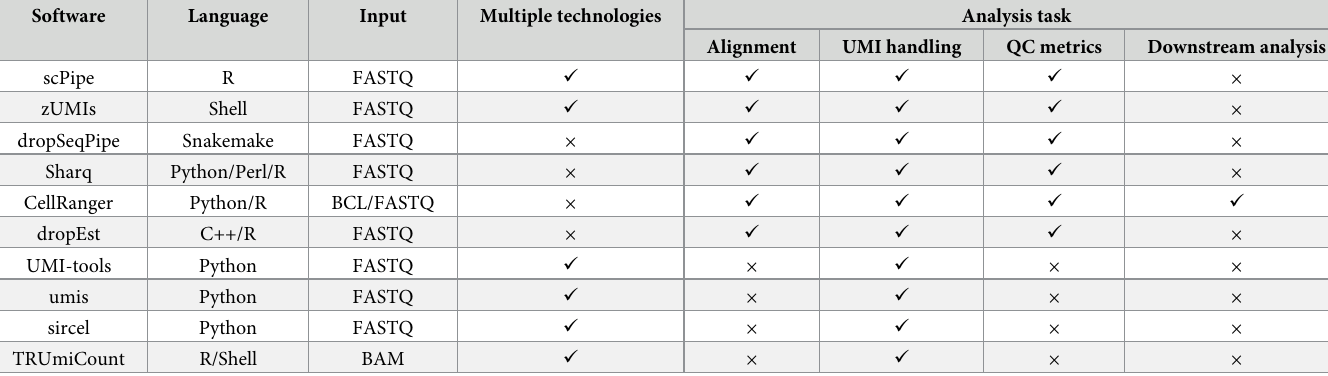
Table 1. Summary of the data preprocessing software currently available for scRNA-seq analysis and the particular tasks covered by each package. Software